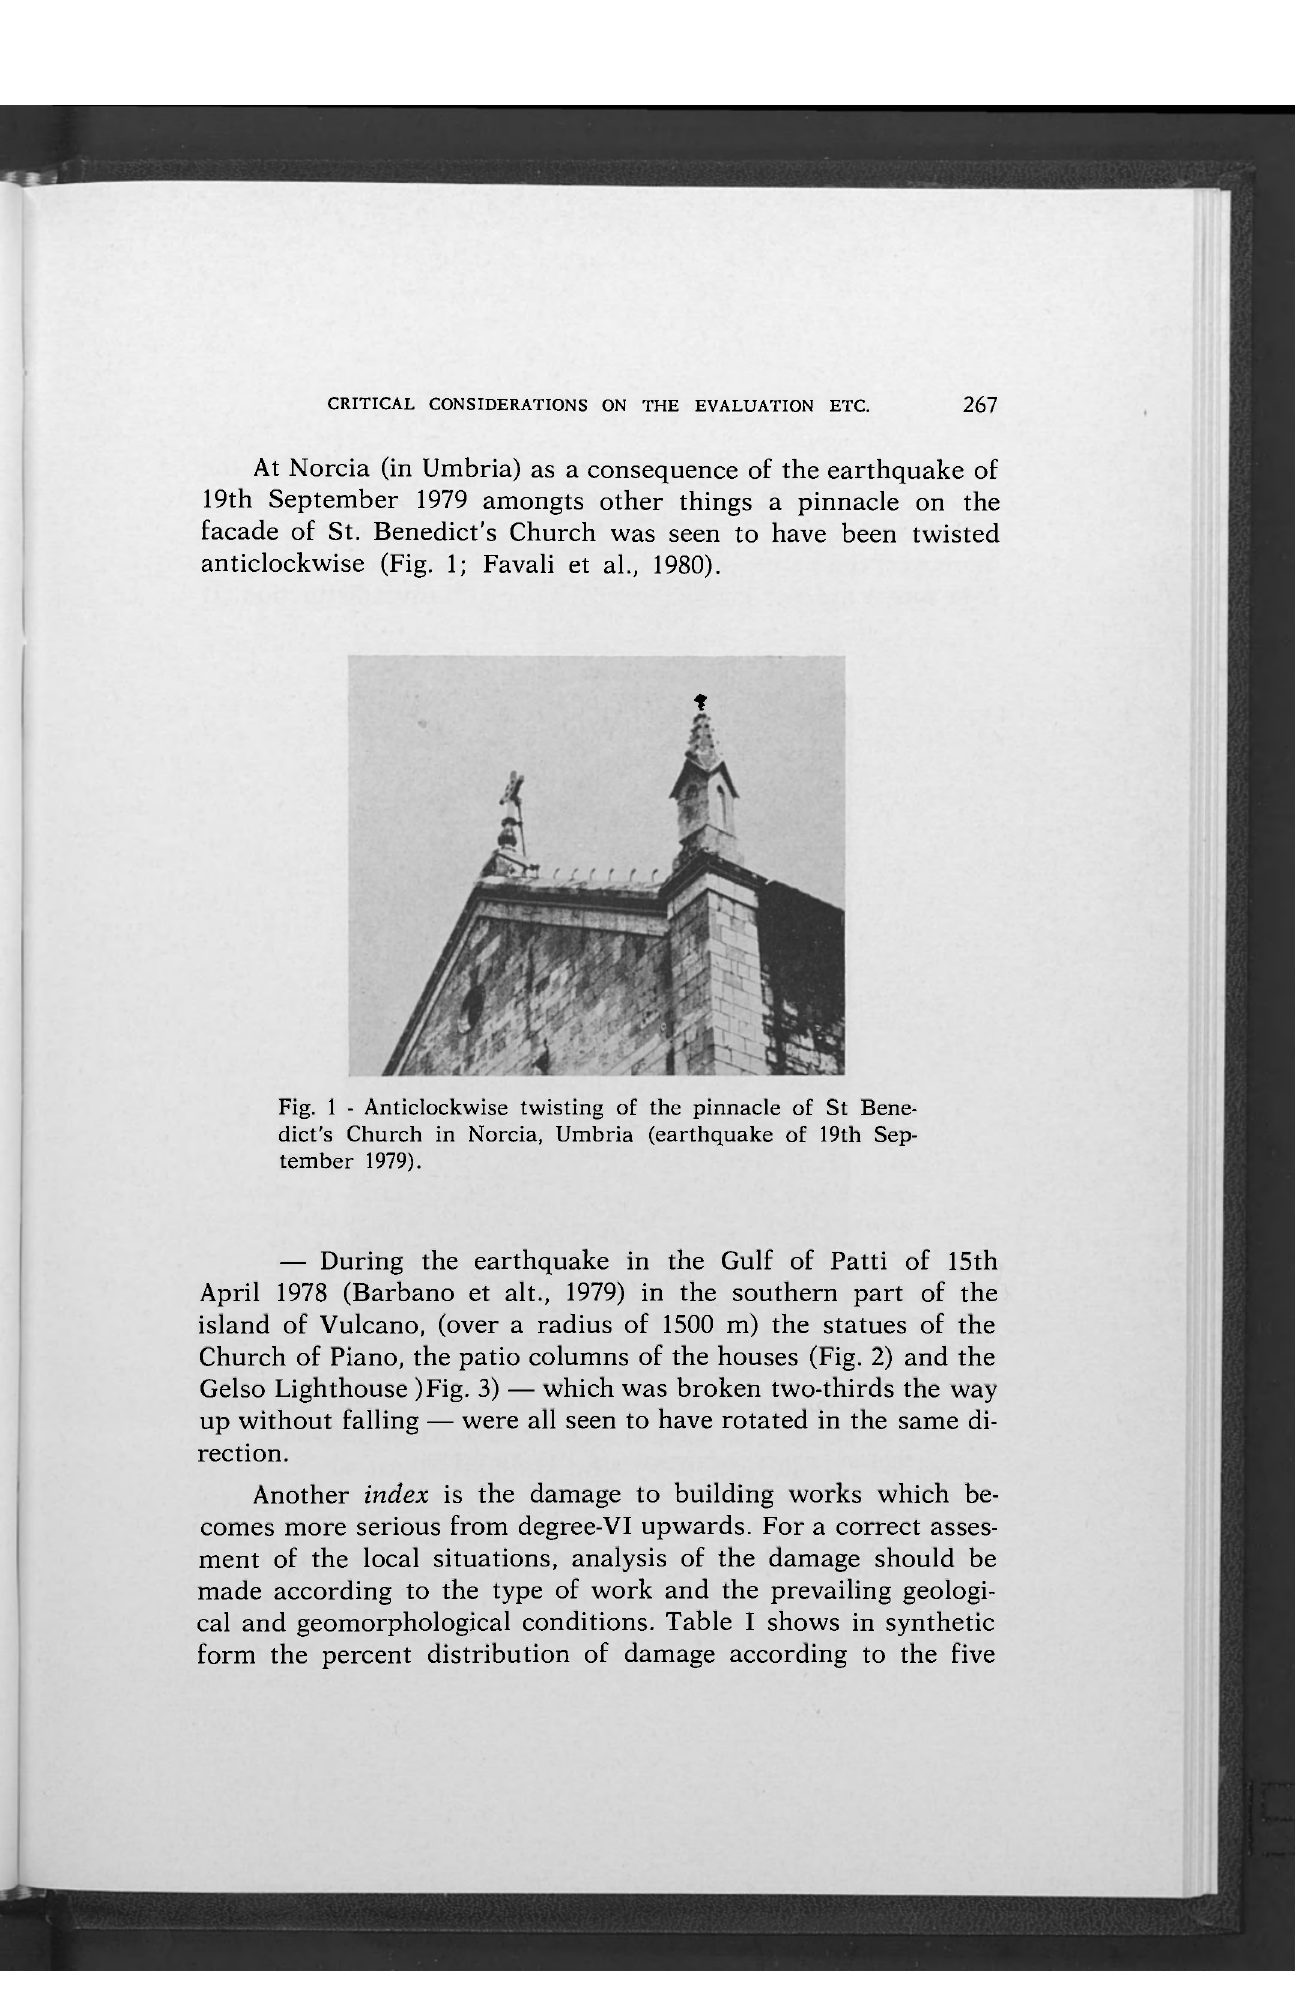
Fig. 1 - Anticlockwise twisting of the pinnacle of St